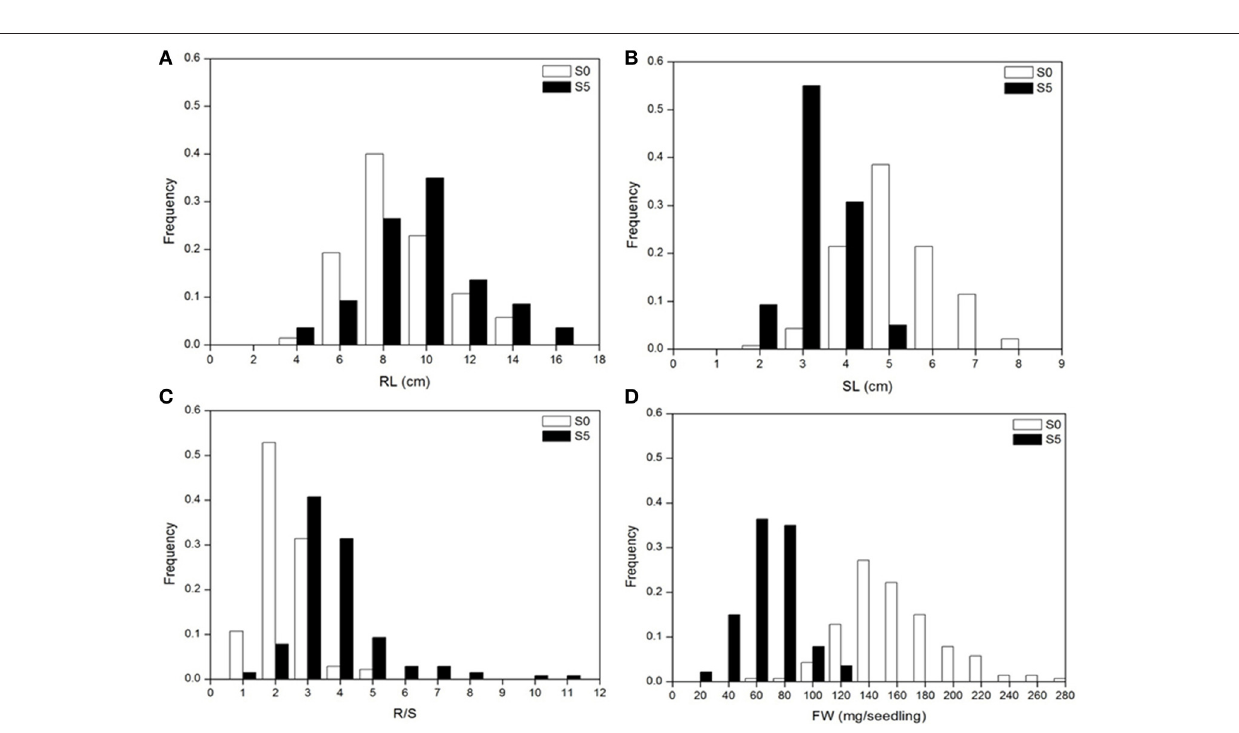
Frontiers in Plant Science |